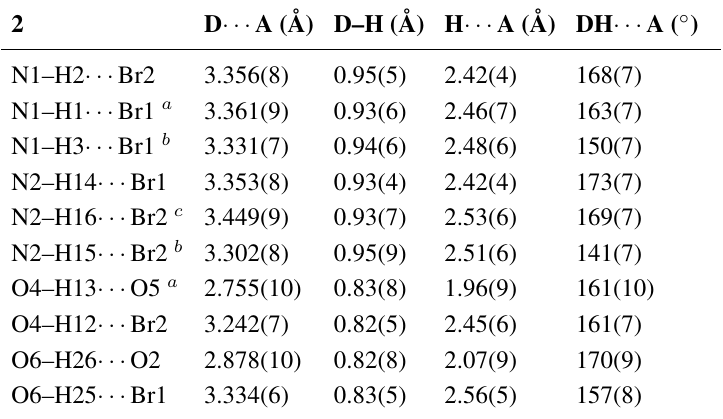
Table 4. Hydrogen bond geometry in 2